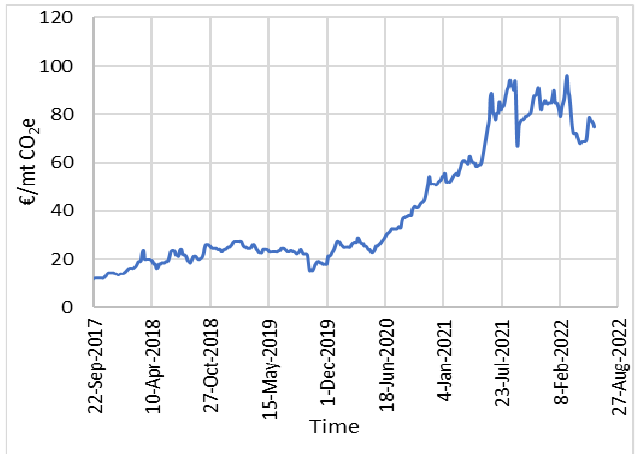
emissions (EUR /mt CO 2